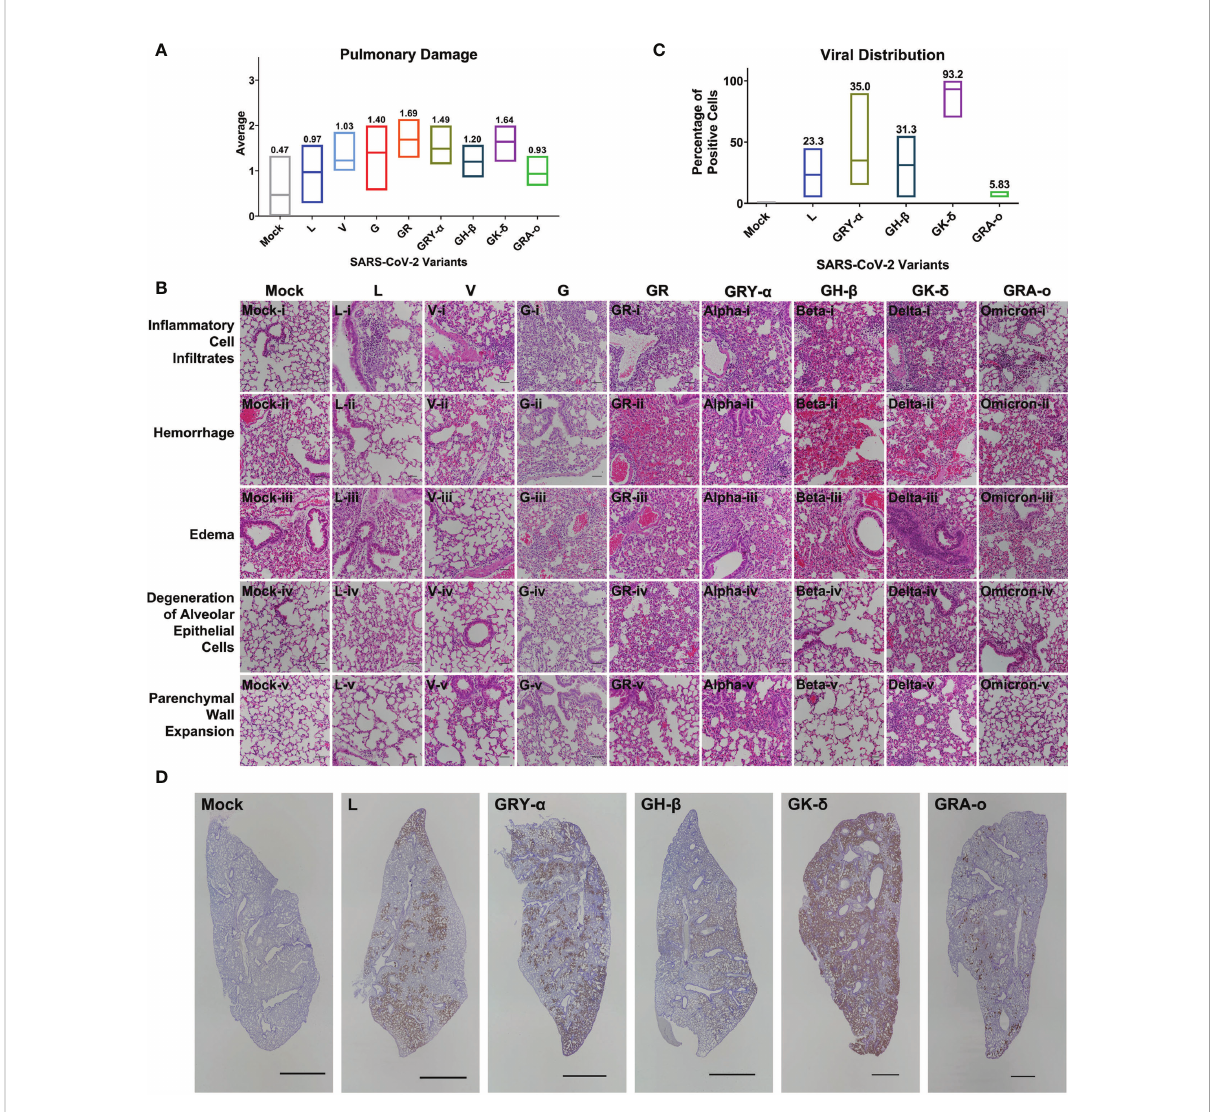
FIGURE 3 Histopathological and immunohistochemical analyses of lung sections from K18-hACE2 mice following infection with SARS-CoV-2 at 4 dpi. (A) Histopathological scoring of lung damage by evaluating the extent and areas of pulmonary involvement based on 6 criteria: in fl ammatory cell in fi ltrates, hemorrhage, edema, degeneration of alveolar epithelial cells, parenchymal wall expansion and bronchiole epithelial cell damage, assigned respectively with a score of 0 – 3. The average of the 6 parameters from mice for each group was regarded as the fi nal histopathological scoring. Mice following mock infection are representative of n=3 per group while mice infected with SARS-CoV-2 are representative of n=7 per group (n=5 for GK- d , and n=6 for GRA-o). (B) Hematoxylin and eosin staining of lung sections from mock- or SARS- CoV-2-infected K18-hACE2 mice. H&E-stained lung sections demonstrated massive in fl ammatory cell in fi ltrates, hemorrhage and thickened interalveolar septa in the mice following SARS-CoV-2 inoculation. Hemorrhage was observed in the mock-infected mice could be due to a crushing artifact and damaged capillary walls during tissue handling at necropsy. 50x total magni fi cation, scale bars = 50µm. (C) Percentage of SARS-CoV-2 nucleocapsid protein positivity in the FFPE lung tissues infected with L, GRY- a , GH- b , GK- d and GRA-o. (D) Detection of SARS- CoV-2 nucleocapsid protein (brown staining) showed the virus was predominantly found in alveolar septa and pneumocytes, but not bronchiole regions. DAB chromogen and hematoxylin counterstain were used. Each image is representative of n=7 per group (L, V, G, GR, GRY- a , GH- b ), n=5 (GK- d ), n=6 (GRA-o), n=3 (mock). 5x total magni fi cation, scale bars =